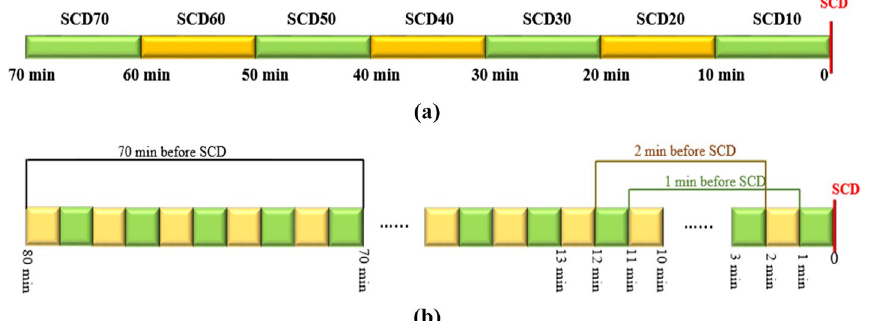
Fig. 2 The segmentation of HRV